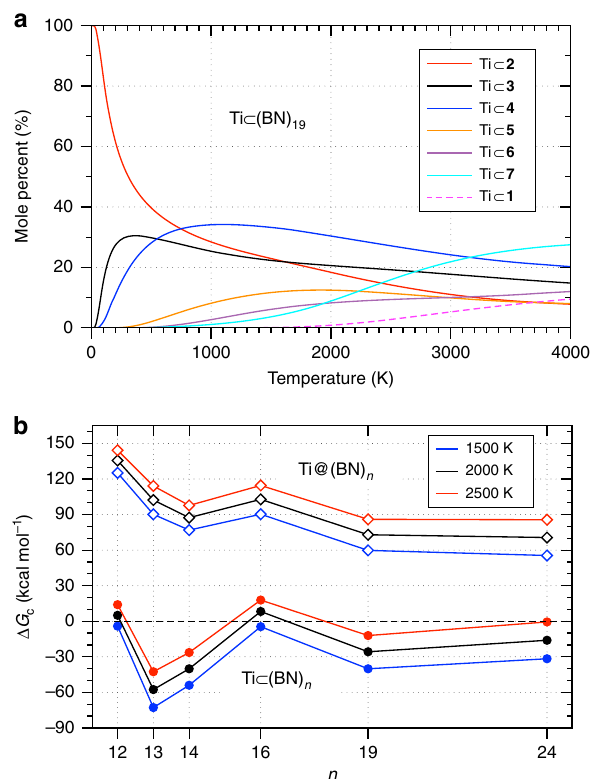
Fig. 5 Relative concentrations and complexation free energies of Ti(BN) n at various temperatures. a DFT predicted mole fractions of the major products by a thermodynamically controlled synthesis of Ti(BN) 19 , as a function of temperature up to 4000 K. The solid lines correspond to the six lowest energy isomers and the dashed line denotes the isomer with cage form 1 . b Gibbs free energies of complexation of Ti(BN) n ( n ¼ 12 ; 13 ; 14 ; 16 ; 19 ; 24), Δ G